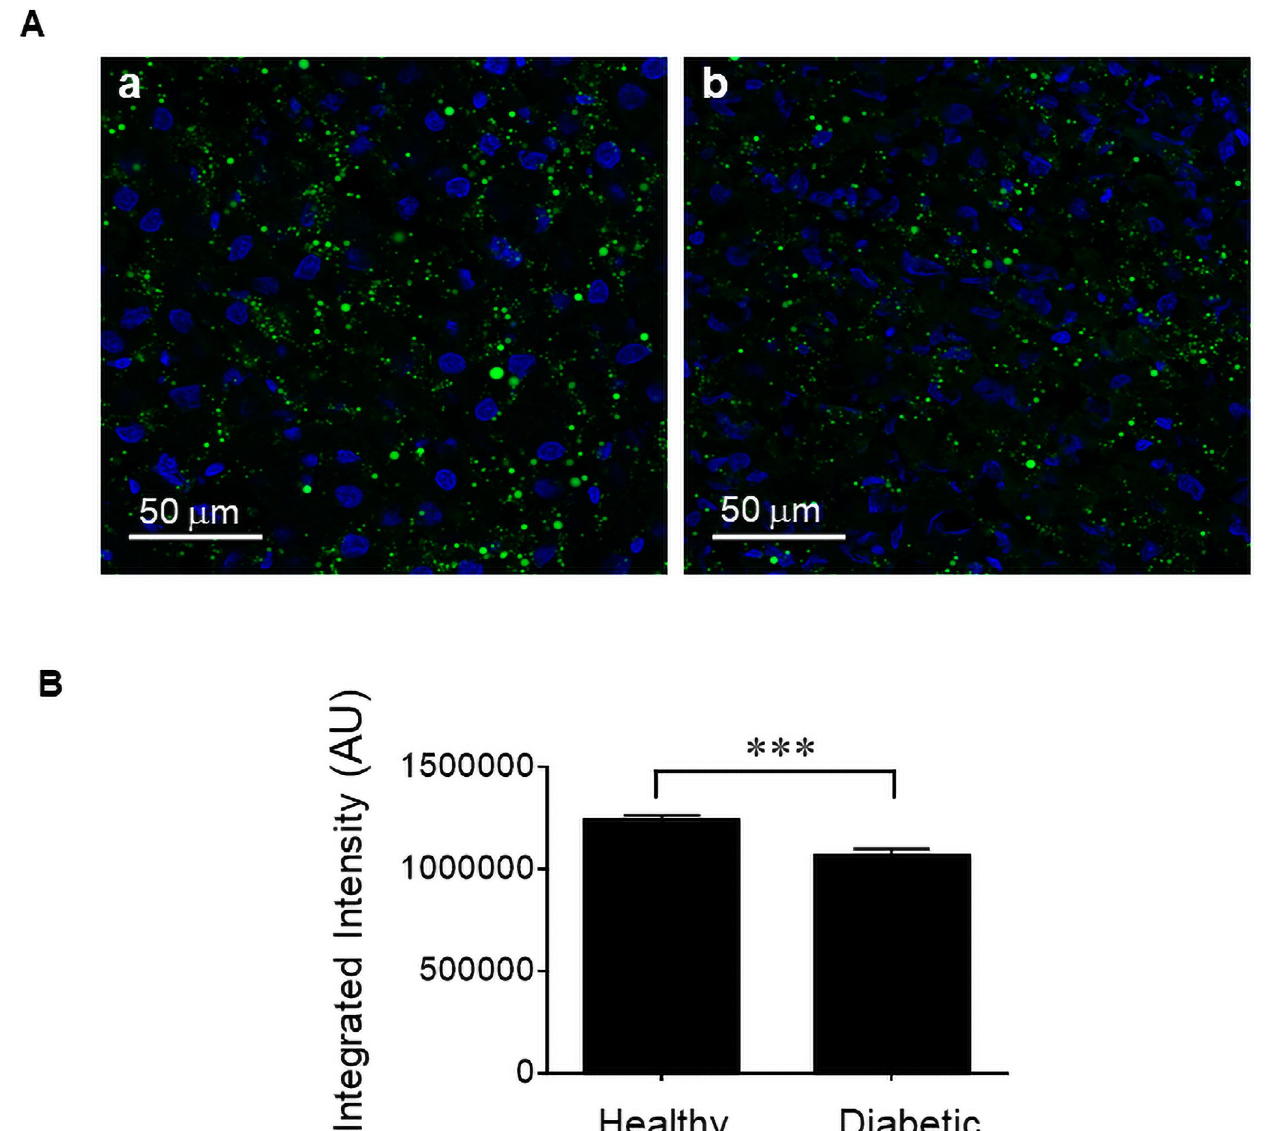
Fig 10. Assessment of lipid accumulation in the liver. (A) Panels a and b show representative images of Nile red staining of frozen liver sections isolated from healthy and diabetic rats, respectively. Fluorescent images were obtained using a 40X objective in an Olympus FluoView confocal microscope. (B) Integrated fluorescent intensity over number of nuclei for each liver section was determined using ImageJ image processing and analysis program. Data are the means ± SEM of ~26–30 liver sections from 3 rats per condition.